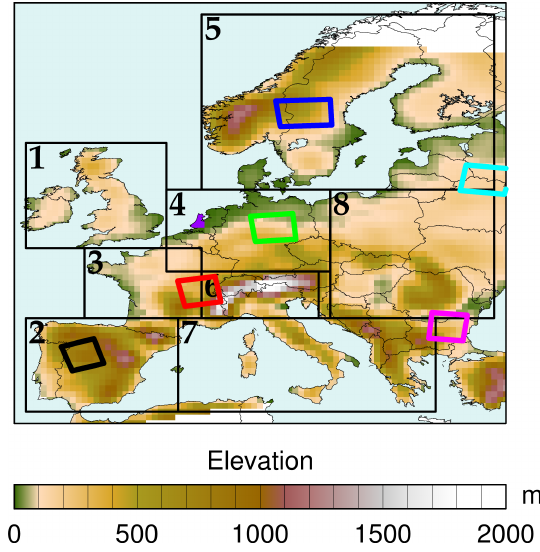
Figure 1. E-OBS descriptors for the reference period (1971–2000). Left side: descriptors for cold and wet extremes in winter (DJF) (Ta < 10th percentile and Pa > 75th percentile). Right side: descrip- tors for hot and dry extremes in summer (JJA) (Ta > 90th per- centile and EDI < 25th percentile). Descriptors were calculated for a moving window over nine grid points and values assigned to the center grid point (see text). Boxes show the PRUDENCE regions (http://ensemblesrt3.dmi.dk/quicklook/regions.html). Table 1. ECA&D station